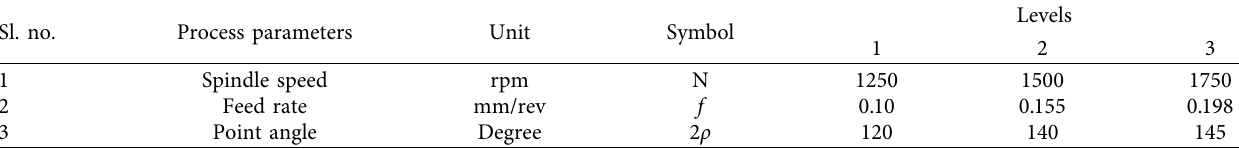
Table 1: Process parameters and their levels.